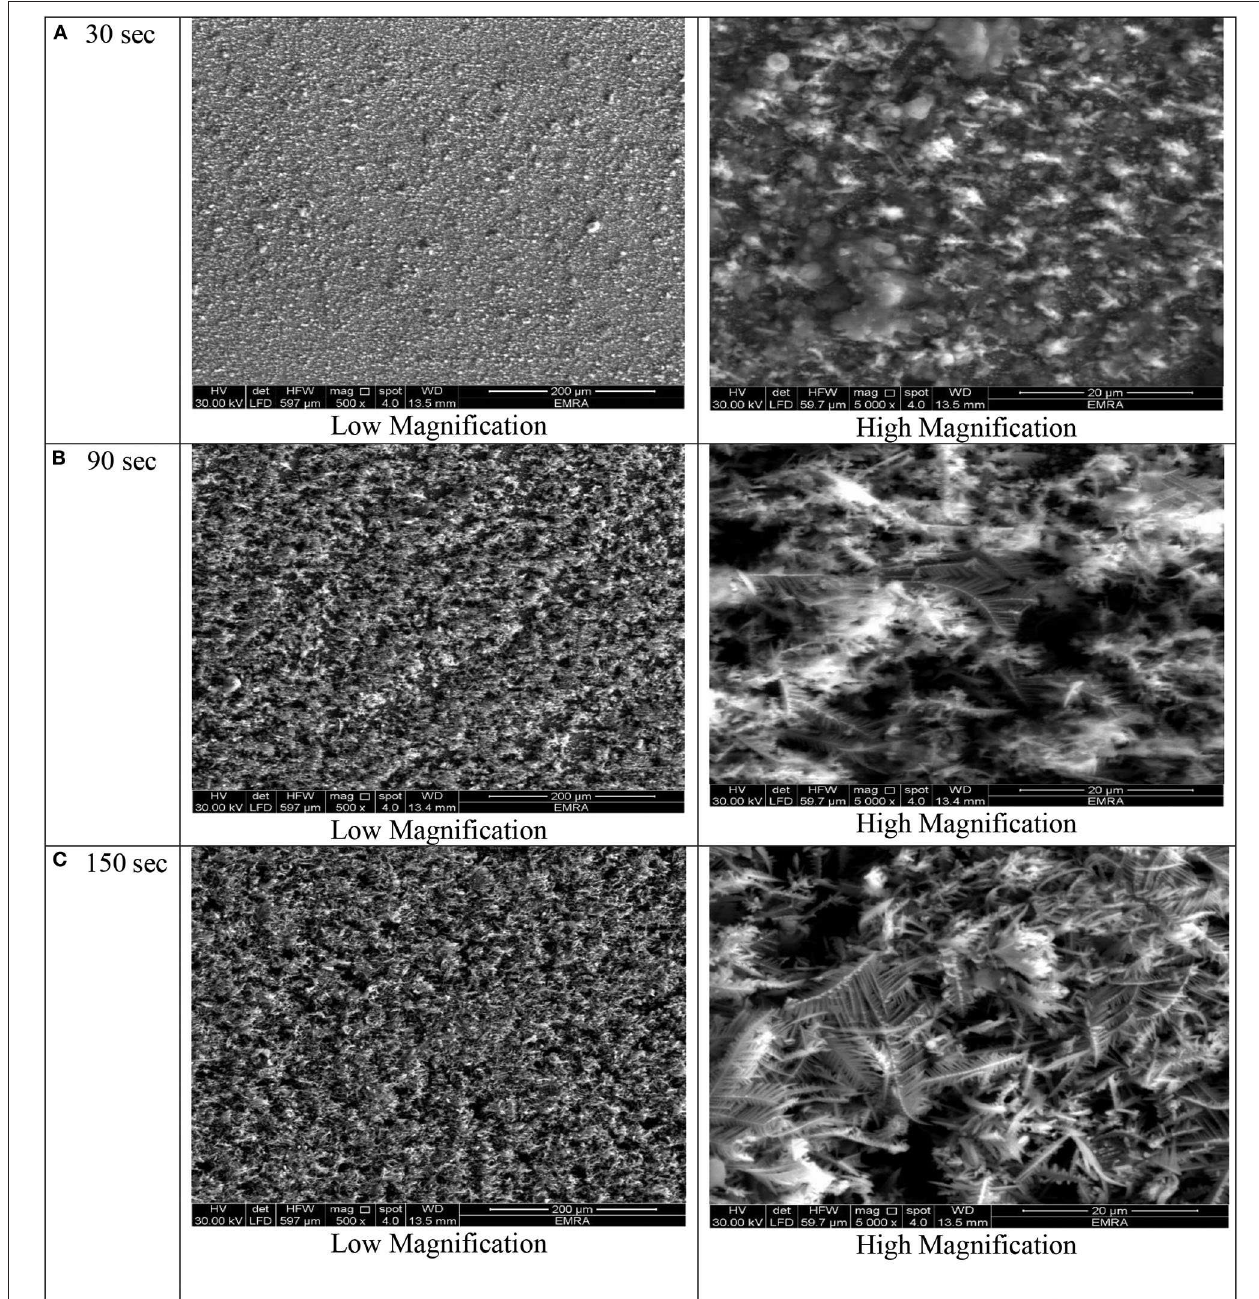
FIGURE 3 | SEM micrographs of porous Ni–Cu layers electrodeposited on AISI 304 stainless steel for (A) 30s, (B) 90s, (C) 150s at current density of 1.5 mA/cm 2 .